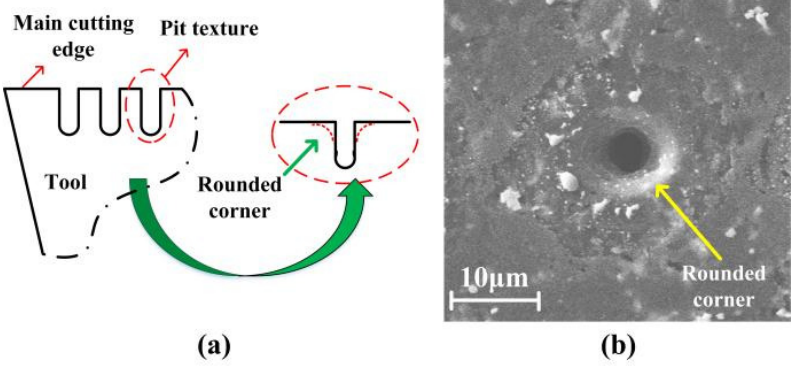
Figure 4. ( a ) Schematic diagram of micro-pits with rounded corners; ( b ) SEM image of one-micro pit before cutting.